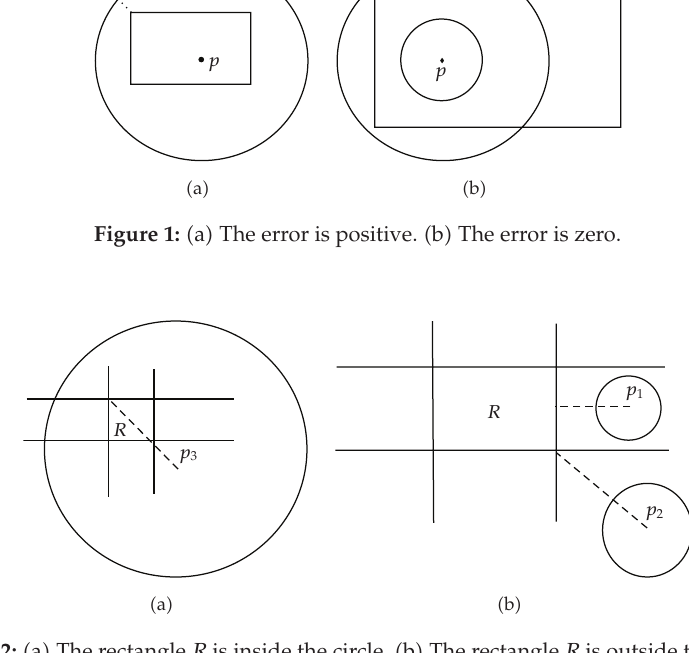
Figure 2: (cid:3) a (cid:4) The rectangle R is inside the circle. (cid:3) b (cid:4) The rectangle R is outside the